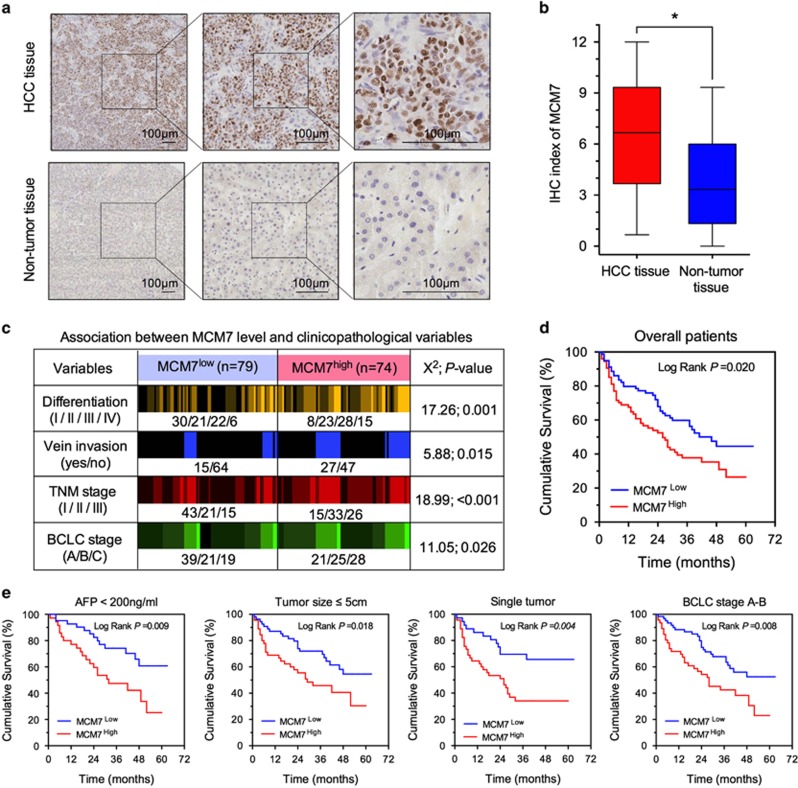
MCM7 was overexpressed in HCC and association with patients' survival. (a) Representative IHC staining images of MCM7 expression in human HCC and nontumor tissues, bar=100 μm. (b) The IHC index of MCM7 in HCC and nontumor tissues. (c) Association between MCM7 expression and clinicopathological variables in HCC patients. (d and e) The cumulative overall survival differences between patients with high and low MCM7 expression in all patients (d) and different subgroups (e). *P<0.05